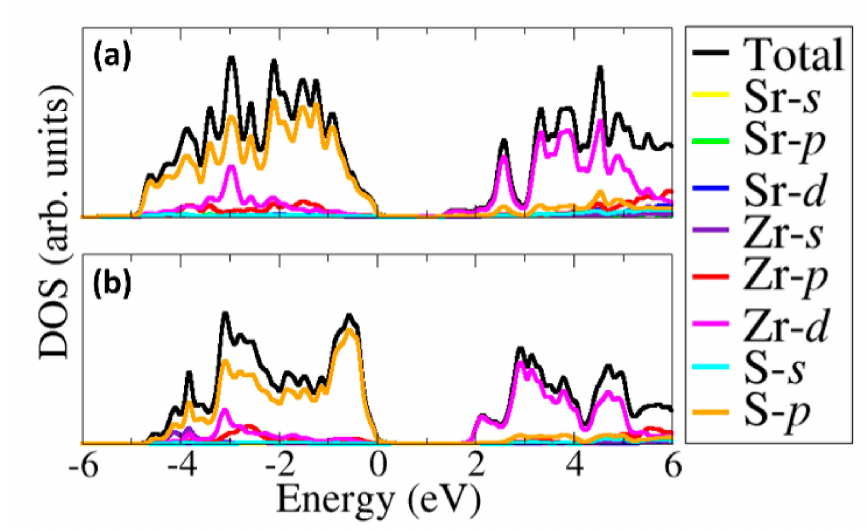
Figure 5. The partial density of states for ( a ) α –SrZrS 3 ; and ( b ) β –SrZrS 3